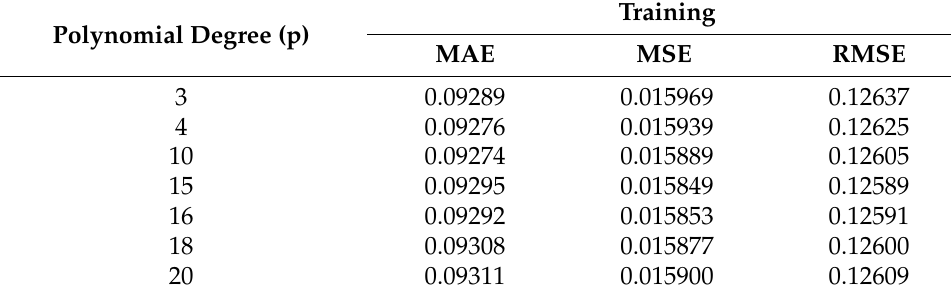
Table 11. PR: testing performance